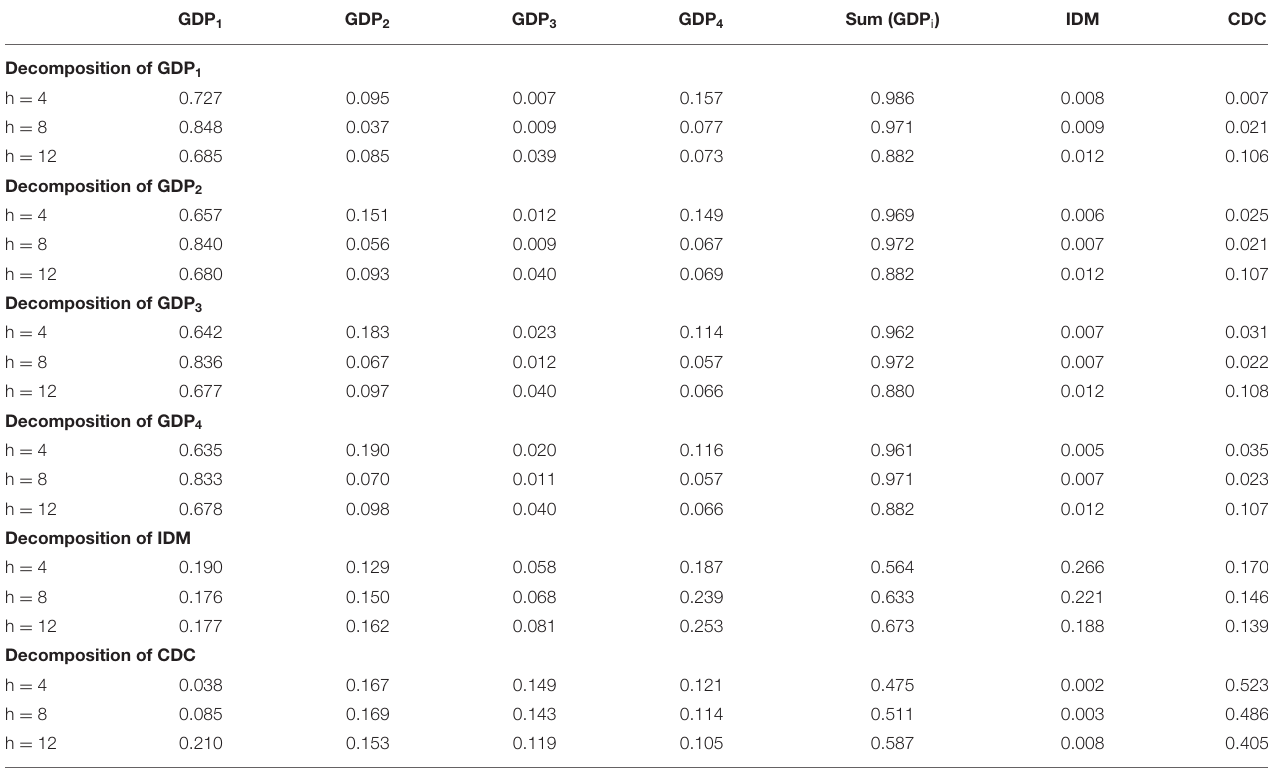
TABLE 4 | Forecast error variance decomposition of MF-VAR